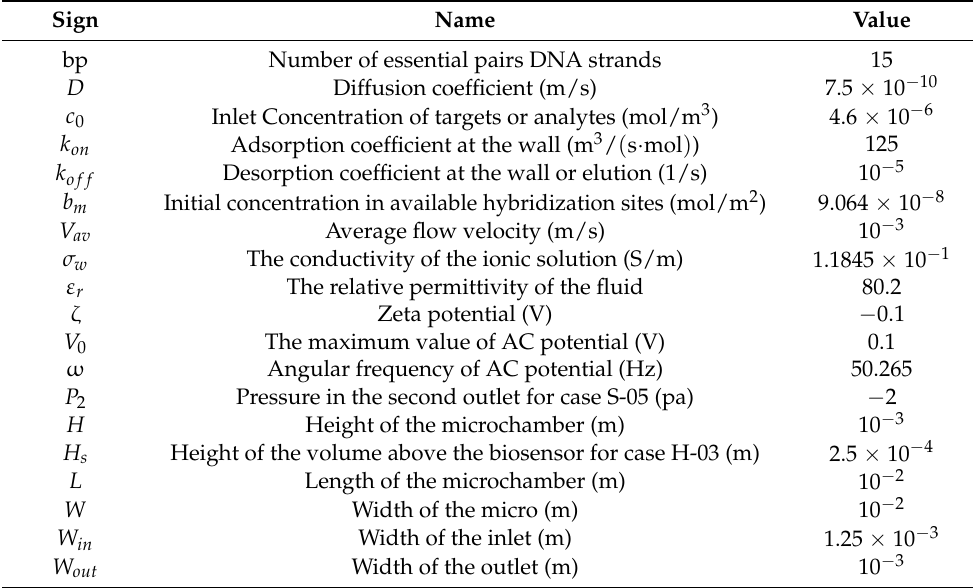
Table 1. The experimental properties for hybridization of short DNA